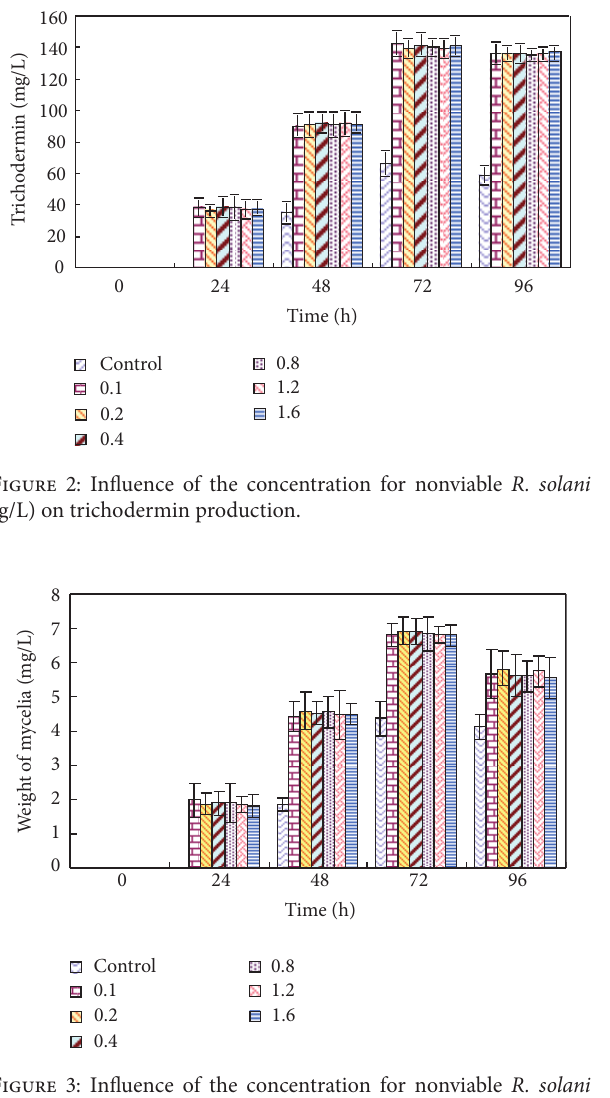
Figure 3: Influence of the concentration for nonviable R. solani (g/L) on T. brevicompactum growth.